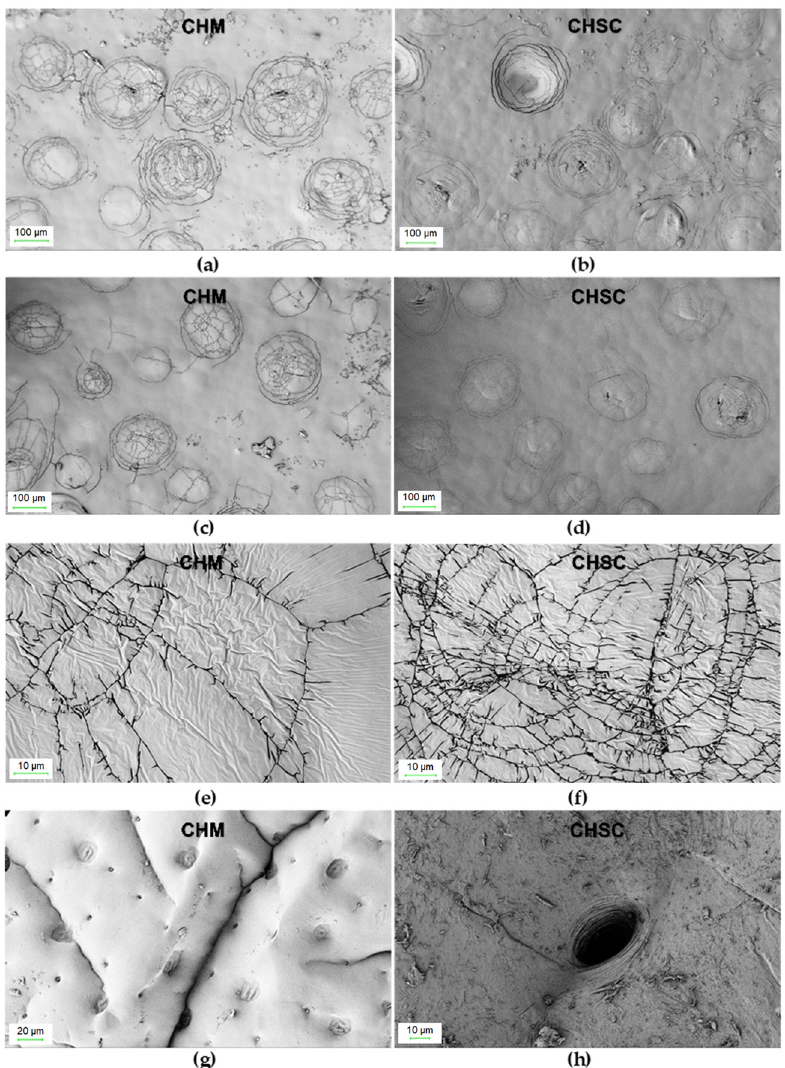
Figure 2. SEM images of: CHM ( a , c , e , g ) and CHSC ( b , d , f , h ) at different magnifications.